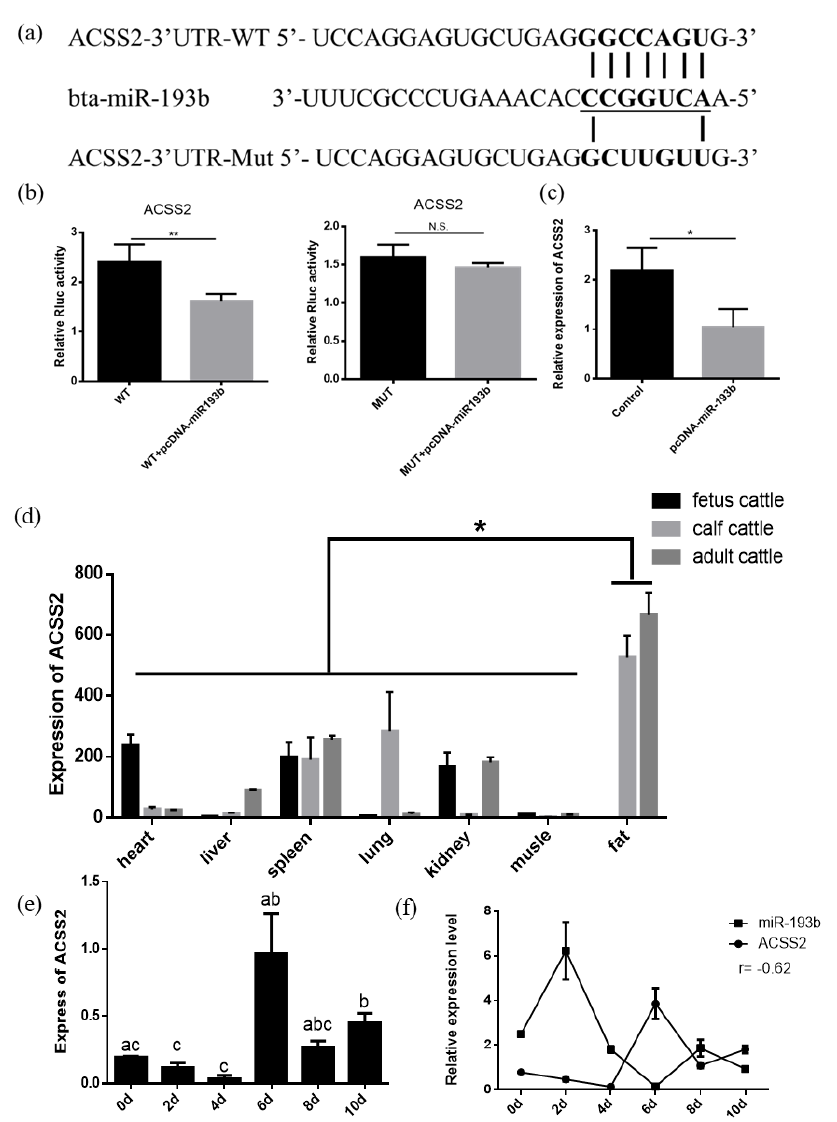
Figure 4. ACSS2 is a target gene of bta-miR-193b. ( a ) The predicted target sites between bta-miR-193b and ACSS2 3’UTR. ( b ) The results of Dual luciferase reporter assay of potential target of bta-miR-193b. ( c ) The relative expression of ACSS2 mRNA in bovine adipose cells was detected by RT-qPCR after a gain of bta-miR-193b. ( d ) The expression profile of ACSS2 , in fetal, calf, and adult bovines. ( e ) The expression dynamics of ACSS2 during adipocyte di ff erentiation determined by RT-qPCR. ( f ) The expression characteristic of bta-miR-193b and ACSS2 , in the di ff erentiation stages of bovine adipose cells. Di ff erent letters (a, b and c) represent significant di ff erences as follows: p < 0.05; * p < 0.05, ** p < 0.01; N.S. represent